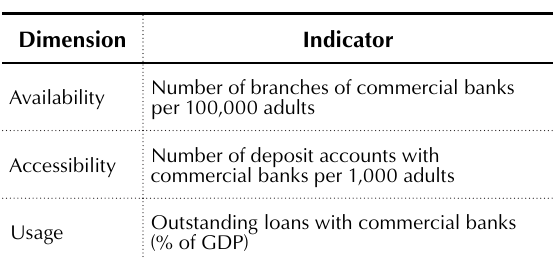
Table 1. Indicators of the JFII